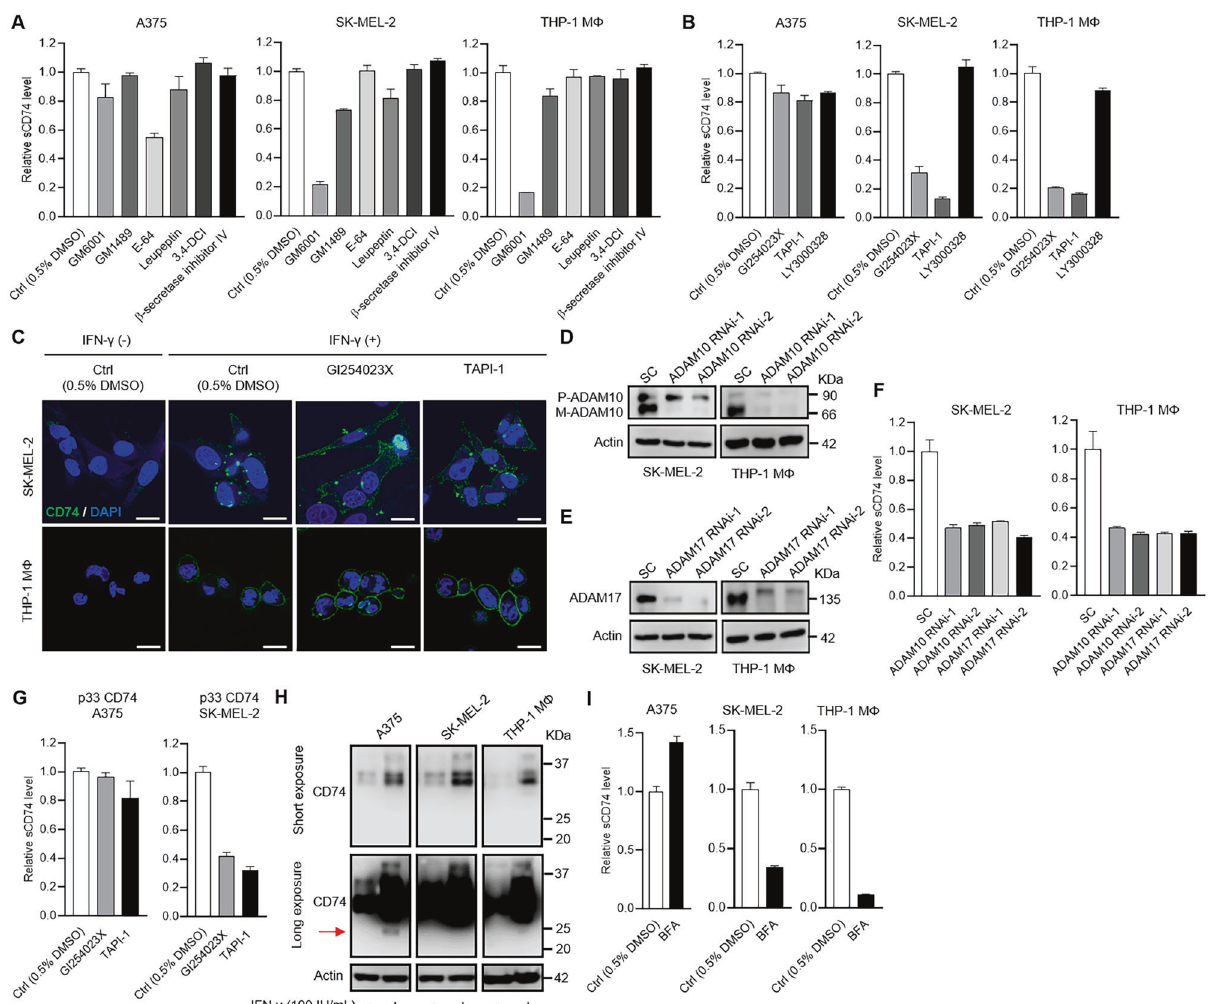
Fig. 3 Protease-inhibitory assay in melanoma cells and THP-1-derived macrophages. A , B A375, SK-MEL-2, and THP-1 M Φ were treated with broad protease inhibitors ( A ), including GM6001 (MMP and ADAM inhibitor), GM1489 (MMP inhibitor), E-64 (cysteine inhibitor), leupeptin (serine, cysteine, and threonine inhibitor), 3,4-DCI (serine inhibitor), and β -secretase inhibitor IV (BACE inhibitor) or selective inhibitors ( B ), including GI254023X (ADAM10 inhibitor), TAPI-1 (ADAM17 inhibitor), and LY3000328 (cathepsin-S inhibitor) under 500 IU/mL IFN- γ stimulatory conditions. Release of sCD74 in supernatants was measured by ELISA ( n = 3), and the fold change relative to sCD74 levels in supernatants of cells treated with 0.5% DMSO is shown as bar graphs. C Representative images of immunocytochemical staining of cell-surface CD74 in SK- MEL-2 and THP-1 M Φ treated with GI254023X and TAPI-1 under 500 IU/ml IFN- γ stimulation. Two cell lines were immunostained with CD74 (green) and DAPI (blue). Scale bar = 20 μ m. D , E Ef fi cacies of two individual siRNAs in knocking down ADAM10 expression ( D ) and ADAM17 expression ( E ) were analyzed by WB in SK-MEL-2 and THP-1 M Φ . SC siRNA was used as a control. F Release of sCD74 in supernatants was measured by ELISA in SK-MEL-2 and THP-1 M Φ transfected with SC siRNA, ADAM10 RNAi-1 and -2, and ADAM17 RNAi-1 and -2 under 500 IU/ mL IFN- γ stimulatory conditions. Bar graphs show the fold change relative to sCD74 levels in supernatants of cells transfected with SC siRNA ( n = 3). G A375 and SK-MEL-2 infected with lentivirus-expressing p33 CD74 were treated with GI254023X and TAPI-1 under basal conditions. Release of sCD74 in supernatants was measured by ELISA ( n = 3), and the fold change relative to sCD74 levels in supernatants of cells treated with 0.5% DMSO is shown as bar graphs. H WB analysis of CD74 expression in A375, SK-MEL-2, and THP-1 M Φ with or without 100 IU/mL IFN- γ stimulation after a short exposure (upper) and a long exposure (lower). Cell lysates precipitated with acetone were subjected to WB analysis, and actin was used as a loading control. Arrow indicates 25-KDa bands. I A375, SK-MEL-2, and THP-1 M Φ were treated with 100 nM BFA for 24 h under 500 IU/mL IFN- γ -stimulated conditions. Release of sCD74 in supernatants was measured by ELISA ( n = 3) and the fold change relative to sCD74 levels in supernatants of cells treated with 0.5% DMSO is shown as bar graphs. Graph values represent mean ± SD. ADAM